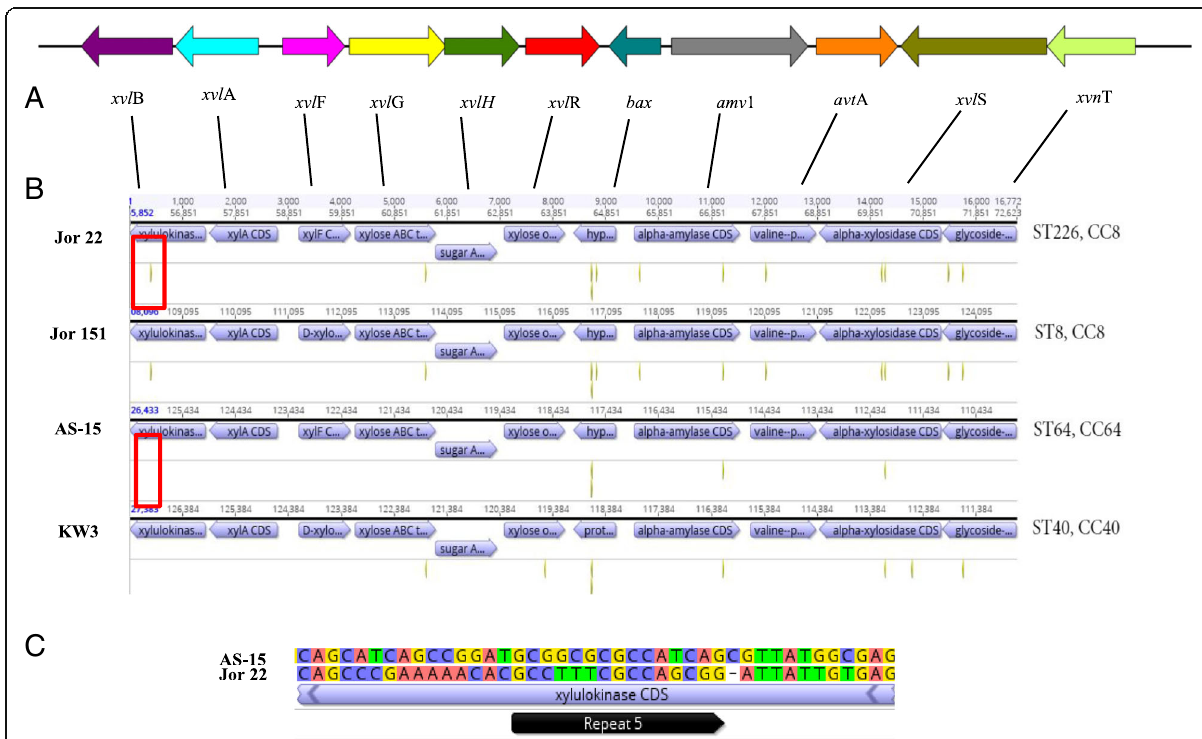
Fig. 3 Schematic map made using XPlas, Map DNA for Mac OS XAp (http://www.iayork.com) showing the annotated xylose utilization operon from MOD1_AS-15 C. sakazakii strain ( a ). Xylose utilization operon for C. sakazakii strains MOD1_Jor22, _Jor151, AS-15,_ KW3 which were extracted from PairWise Alignments using Geneious (https://www.geneious.com/) showing the identical sequence repeat regions which are associated with each gene of the operon and captured using the identical repeat sequence region function in Geneious ( b ). Repeat regions are denoted by bronzed colored lines below each operon gene. These repeated regions are also shown in Additional file 5: Table S5. c Nucleotide sequence alignment captured in Geneious for repeat region five in xylB for MOD1_AS-15 and MOD-1_Jor22 showing the presence of the repeat region in MOD1_Jor22 (56,266 to 56,280, see red box). Note that bax can contain two to three identical repeat regions which suggest that this is an important highly regulated gene. bax has been shown to induce cell apoptosis of Arabidopsis protoplast cells through reactive oxygen independent and dependent processes namely DNA fragmentation, increased vacuolation, and loss of plasma membrane integrity